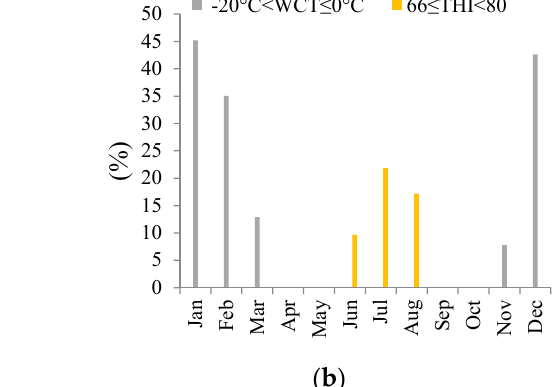
Figure 6. Monthly PM 10 concentrations and meteorological parameters: ( a ): Prec., BL, LCL, ( b ): WCT, THI. Two classes of human discomfort were detected (Figure 6b): uncomfortably cold and uncomfortably hot. Uncomfortably cold represented 40.96% of the total winter days, 3.22% resulting from the spring days, and 2.59% from the autumn days, while uncomfort- ably hot occurred during the summer, exhibiting 16.23% of the total summer days, respec- tively. For the entire studied period, 28.59% of the total days were uncomfortable. Precip- itation has a positive effect, by reducing through wet scavenging the PM 10 concentration. This effect is more significant during summer, when the quantity of precipitation is the highest (avg. 81.44 mm). The monthly PM 10 evaluation shows a reverse trend with the boundary layer and lifting condensation level. There are two categories of accumulation conditions if the values of boundary layer and air pressure are high, strong anticyclonic systems are formed, leading to the Brunt Vaisala effect that often produces thermal inver- sions, favoring pollutant accumulation. The second accumulation condition occurs when the cloud base is low and the relative humidity is high, leading to fog formation. 3.3. Hospital Admission Evaluation Admissions in Ciuc Emergency Hospital due to respiratory and cardiovascular causes were analyzed in detail. The incidence of the disease was examined in five different age groups: [0–5], (5–14], (14–40], (40–60], 60+. In 2010, 2012 and 2014, the number of days with high and very high pollution was higher in comparison with other years, resulting in the surge of hospital admissions. Diseases were found to be most common in the elderly age group 60+ representing 41.3%. The second large number of patients were children; below 5 years old, with 28.9% followed by the patients between (40–60], accounting for up to 20.4%. A lower rate was found in the case of children (5–14] years with 3.4% and young people (14–40] years with 6.0%, respectively. Furthermore, hospital admissions also show a weekly, and monthly cycle. The maximum hospital admission is on Monday and Friday and the minimum on Sunday. The average number of monthly hospital ad- missions shows a maximum in March ( n = 230) and a minimum in August ( n = 122). Most hospital admissions were for P in the children’s age group [0–5] years with 19.5% and in the case of elderly people 60+ years with 14.9% proportion (Figure 7).